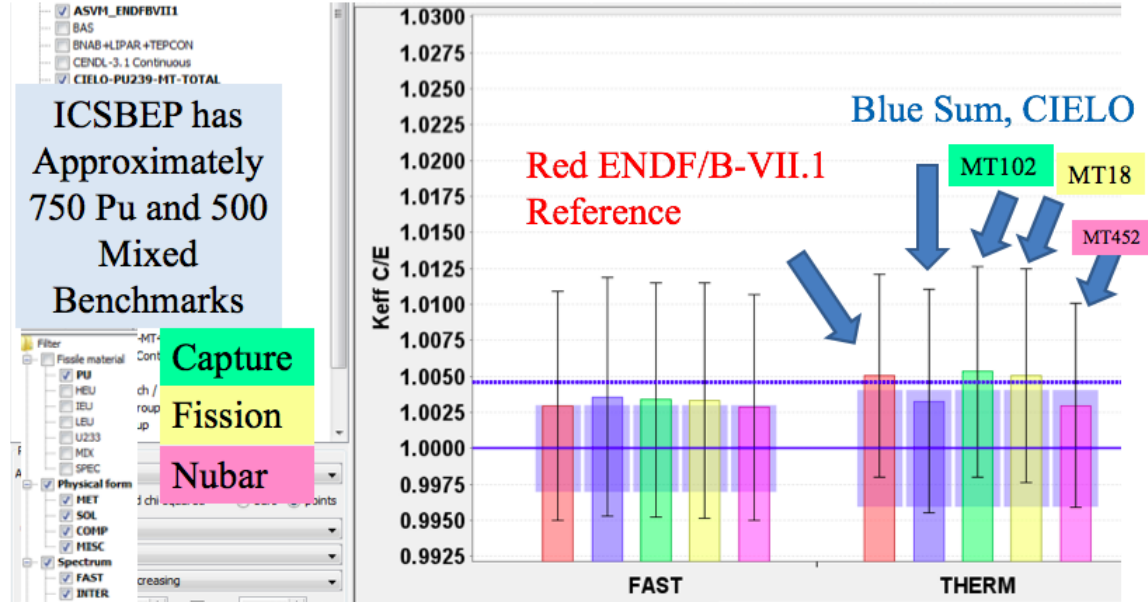
Figure 2. Calculations of 1250 plutonium and mixed criticality benchmarks showing ENDF / B-VII.0 (red), CIELO-1 (blue) and cases where one component of the CIELO-1 evaluations were added to the ENDF / B-VII.1 evaluations: capture cross section (green), fission cross section (yellow) and average neutron multiplicity